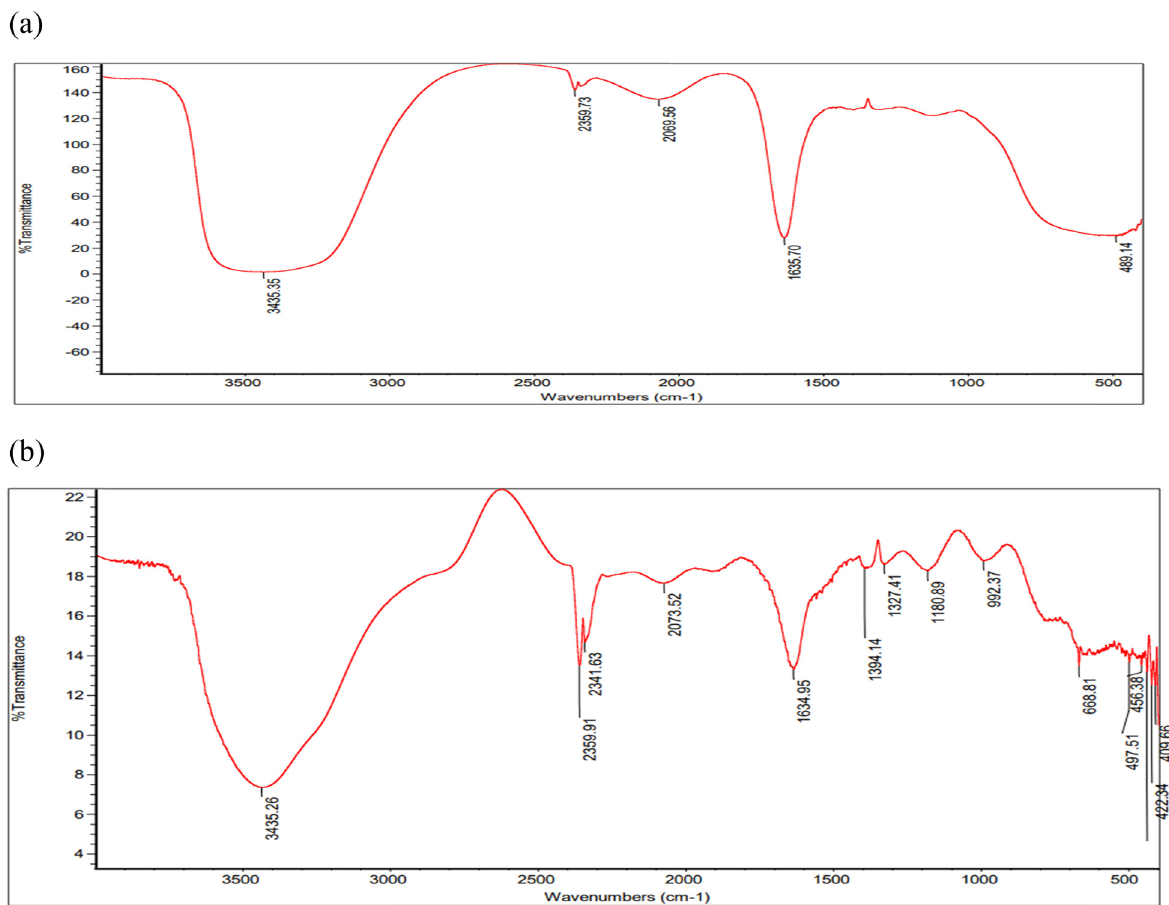
Figure 5: Infrared spectra of ( a ) M. oleifera leaf extract and ( b ) green - synthesized M. oleifera –